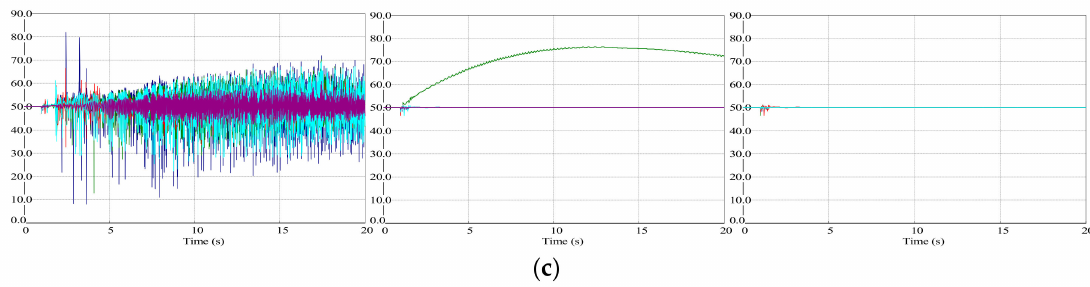
Figure A1. Dynamic trajectories of the test system. ( a ) Rotor angles of major generators ( ◦ ); ( b ) Voltages of end buses on cut-sets (p.u.); ( c ) System frequency (Hz).